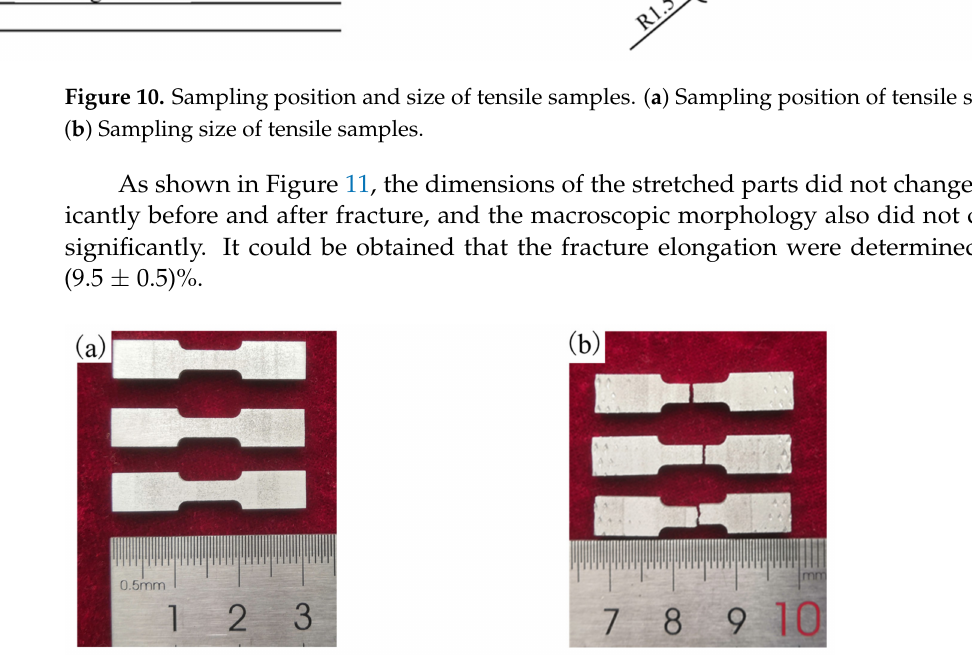
Figure 11. Comparison of macroscopic morphology before and after tensile tests. ( a ) Macromorphol- ogy before tensile tests. ( b ) Macromorphology after tensile